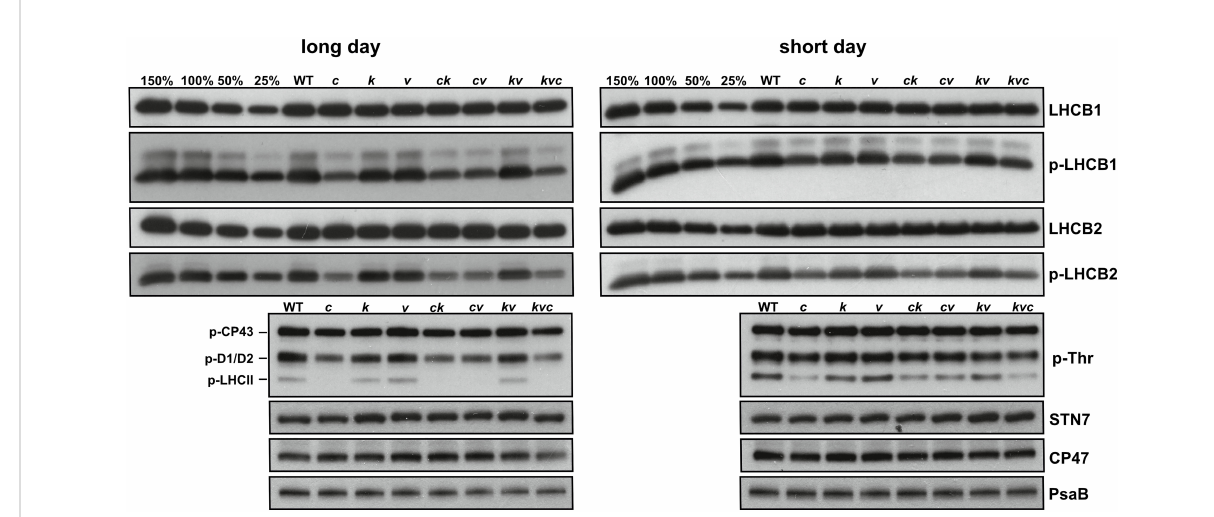
FIGURE 3 Thylakoid protein content and phosphorylation levels during long- and short-day conditions. Wild-type plants and mutants were grown using 16 h light (100 µmol photons m − 2 s − 1 )/8 h dark cycles (long day) for 3 weeks or 8 h light (120 µmol photons m − 2 s − 1 )/16 h dark cycles (short day) for 5 weeks. Immunoblots from thylakoids separated by SDS-PAGE and probed with LHCB1, p-LHCB1, LHCB2, p-LHCB2, p-Thr, STN7, CP47 (PSII) and PsaB (PSI) antibodies are shown. All thylakoids were loaded on equal chlorophyll basis of 0.5 µg, except 3 µg for STN7. 150%, 100%, 50% and 25% of WT samples were used as loading controls. WT – Col-0 , c – clce-2 , k – kea3-1 , v – vccn1-1 , ck – clce-2kea3-1 , cv – clce- 2vccn1-1 , kv – kea3-1vccn1-1 , and kvc – kea3-1vccn1-1clce-2